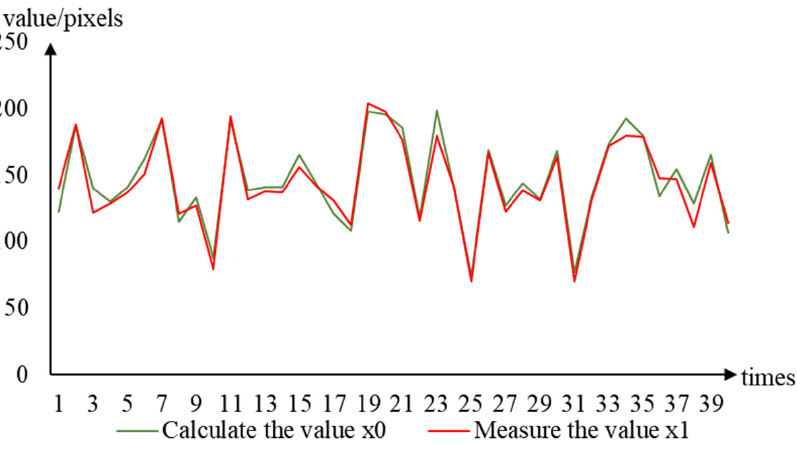
Figure 14. Positioning process diagram. Original image ( A ). H channel image ( B ). Center of mass ( C ) and Lower extreme point ( D ).